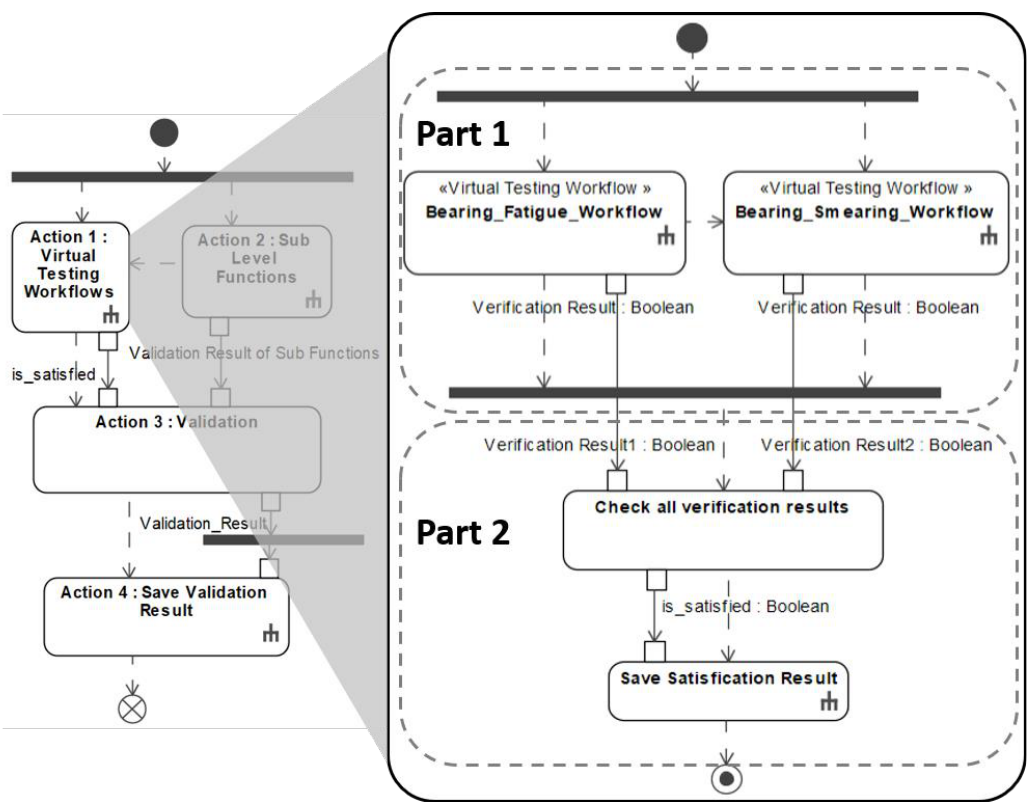
Figure 4. The workflow to check if the solution fulfills the function based on virtual